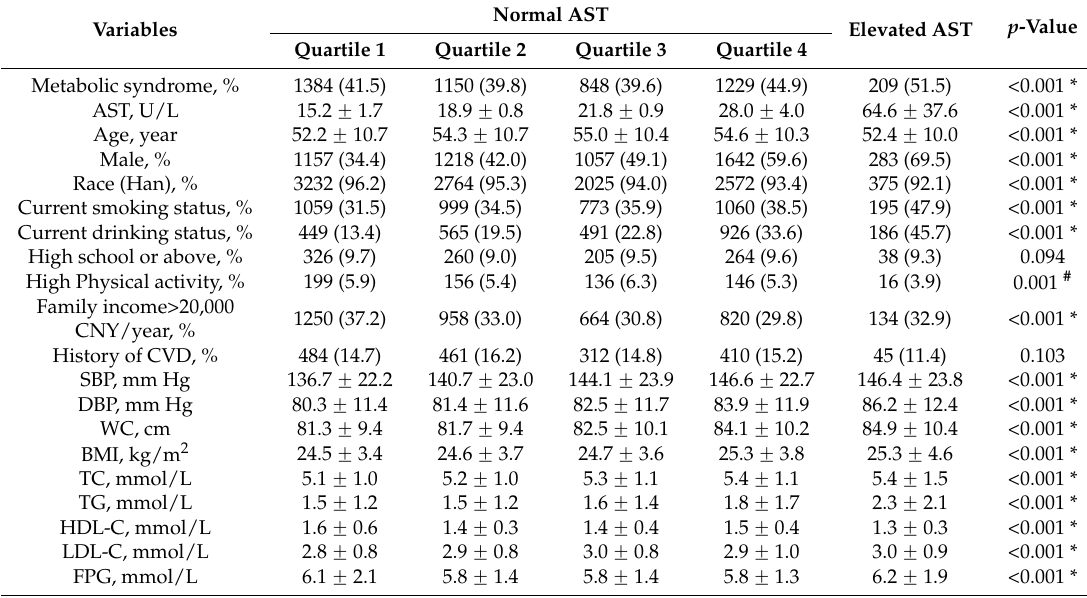
Table 3. Characteristics of subjects according to the AST quartiles ( n = 11,573).